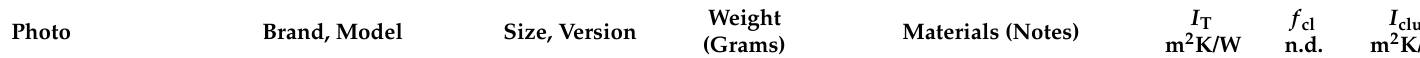
Table 1. Clothing item specifications and their total insulation ( I T ), clothing area factor ( f cl ) and basic clothing insulation ( I clu ). Nr.